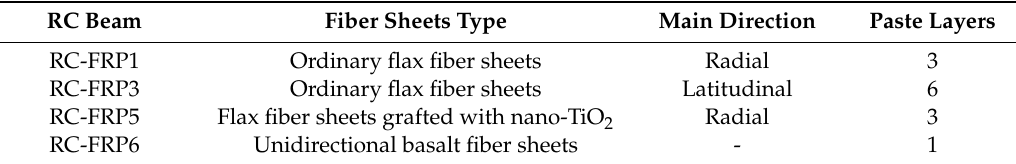
Table 6. Configuration of the reinforcement with fiber sheets.